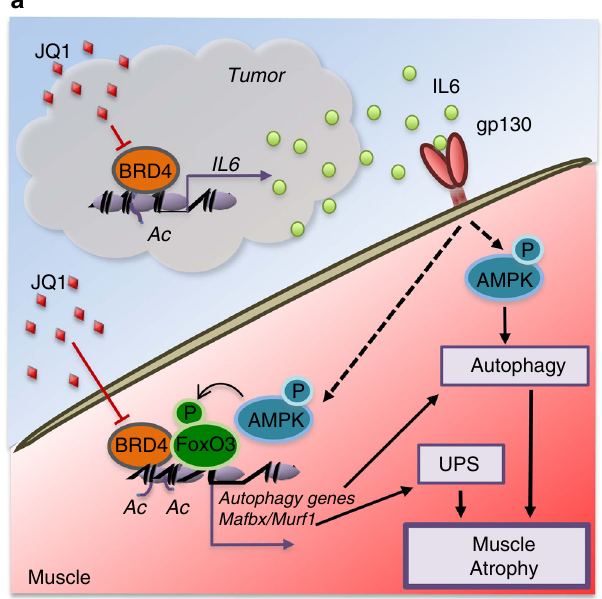
Fig. 10 Proposed mechanism for BRD4 and JQ1 regulation of muscle atrophy during cachexia. a Schematic presentation of BRD4 functions in tumor and muscle, during cancer